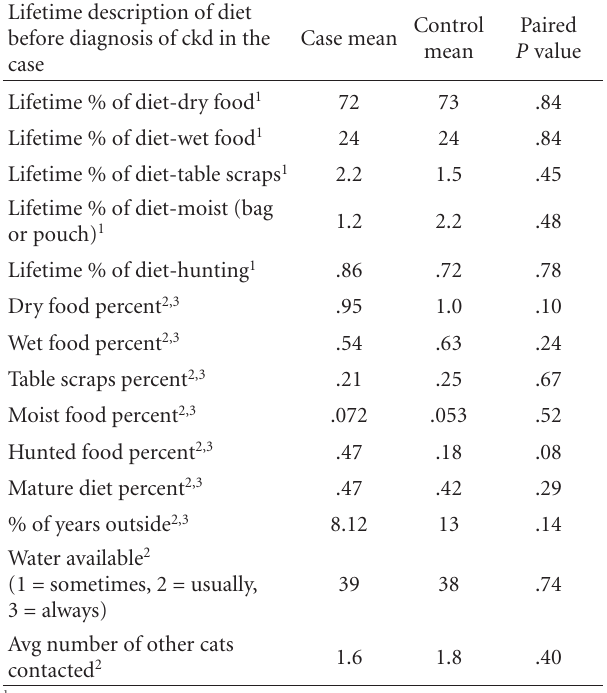
Table 2: Feline-Analysis of Continuous variables regarding obser- vations before the diagnosis of CKD in the Case, analyzed by matched t